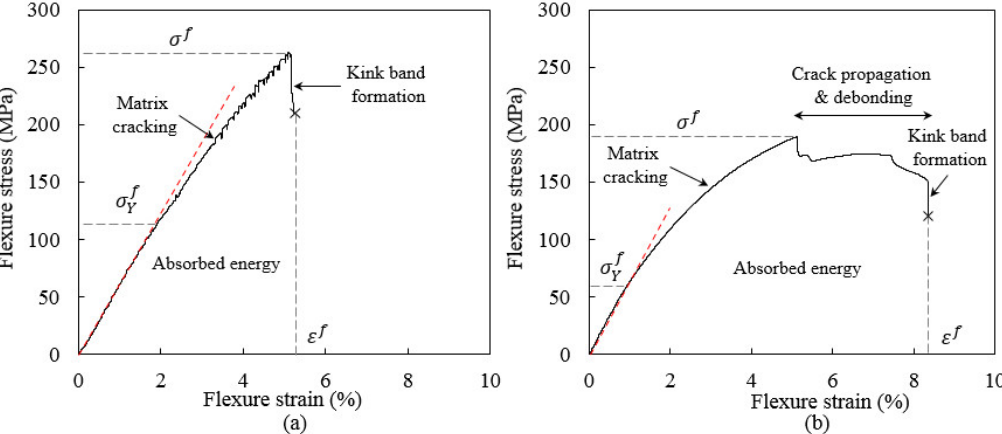
Figure 1. Schematic diagram of typical flexural stress/strain curve of 3D-FRC: ( a ) on-axis S-D curves of 3D-FRC and ( b ) off-axis stress/displacement curves of 3D-FRC. of 3D-FRC and ( b ) off-axis stress/displacement curves of